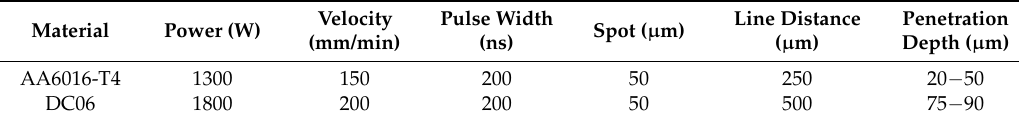
Table 3. Parameters for laser structuring depending on the used materials.